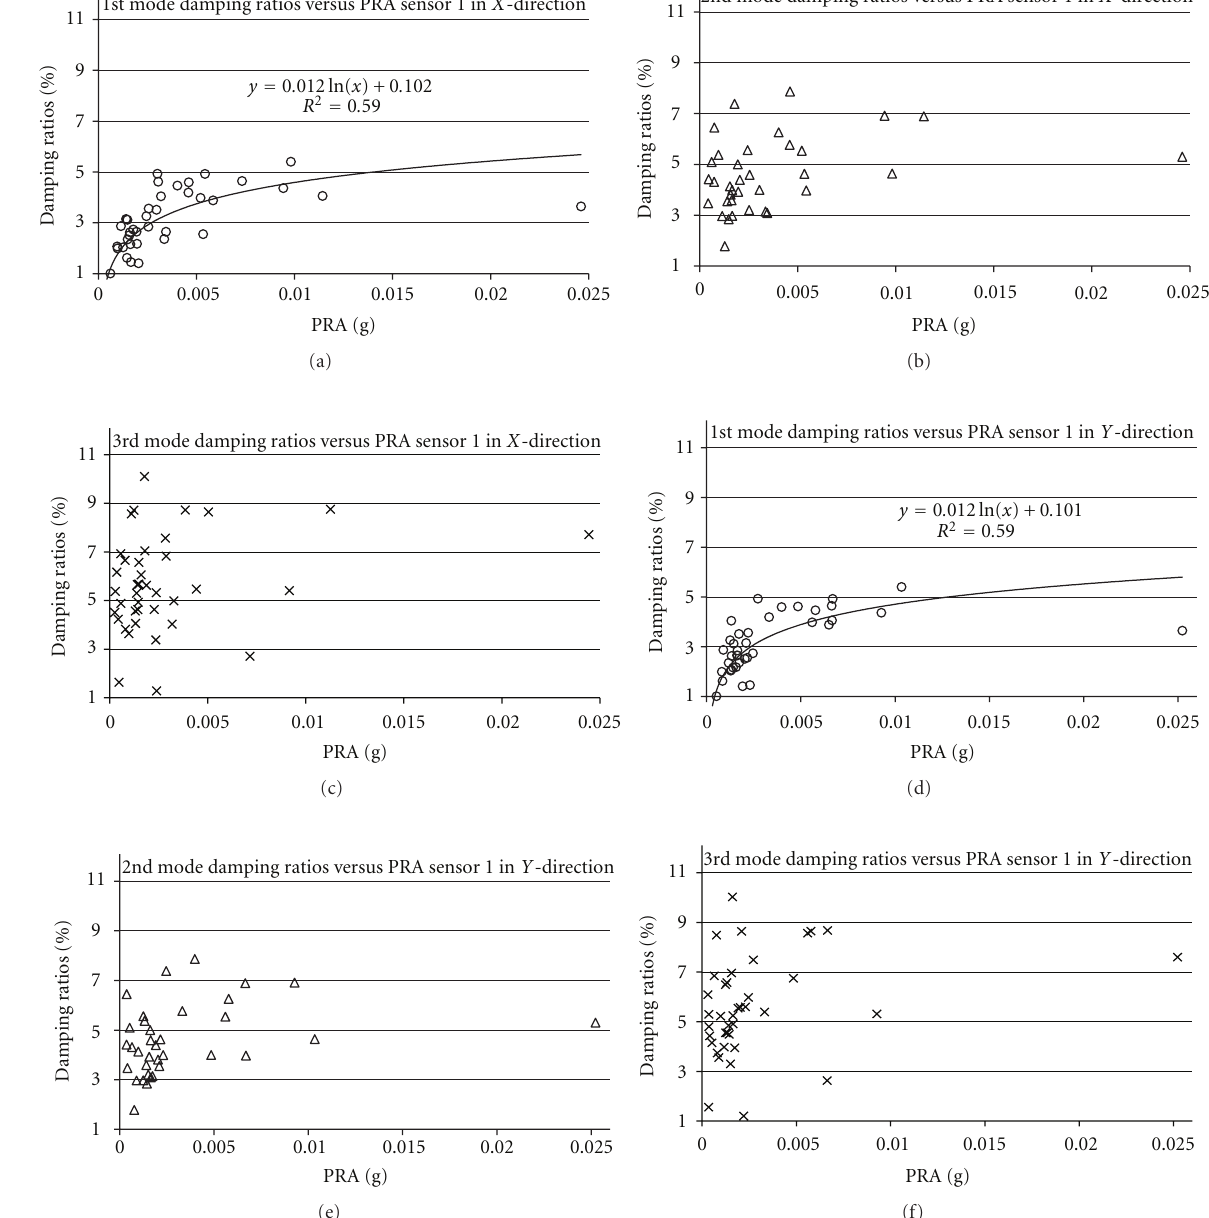
Figure 16: Modal damping ratios of building B for pseudoflexible base case: (a) 1st mode, (b) 2nd mode, (c) 3rd mode versus X -direction PRA of sensor 1; (d) 1st mode, (e) 2nd mode, and (f) 3rd mode versus Y -direction PRA of sensor